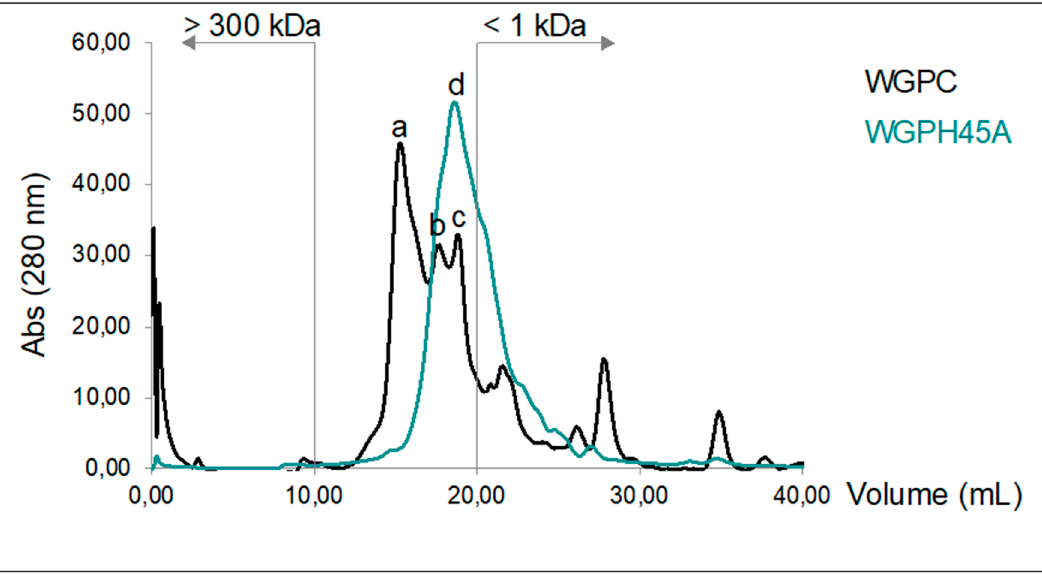
Figure 3. Molecular weight profiles by size-exclusion Fast Protein Liquid Chromatography (FPLC) of WGPC and WGPH45.